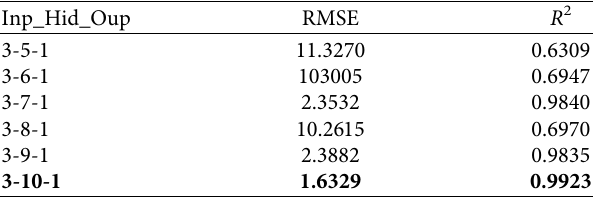
Table 8: Performance of ANN structure of